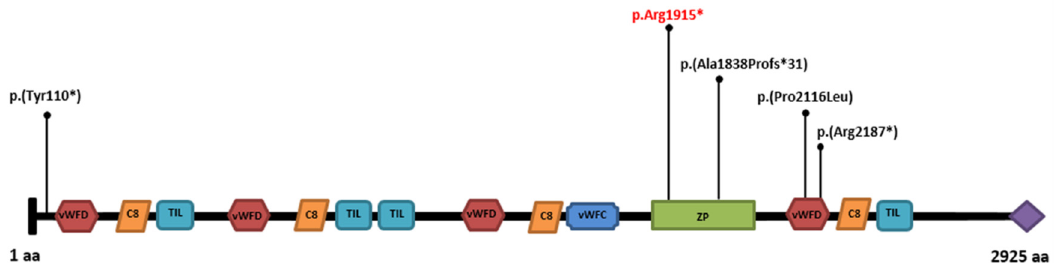
Figure 4. Schematic representation of protein domains of Otogelin [27], encoded by OTOG , with positions of all known deleterious variants published so far, and including the present one [7,8]. The variant identified here is in red. (vWFD, von Willebrand factor type D domain; C8, cystein-rich domain; TIL, trypsin inhibitor-like cysteine-rich domain; vWFC, von Willebrand factor type C domain; ZP, zona pellucida domain; C-terminal cysteine knot-like domain).